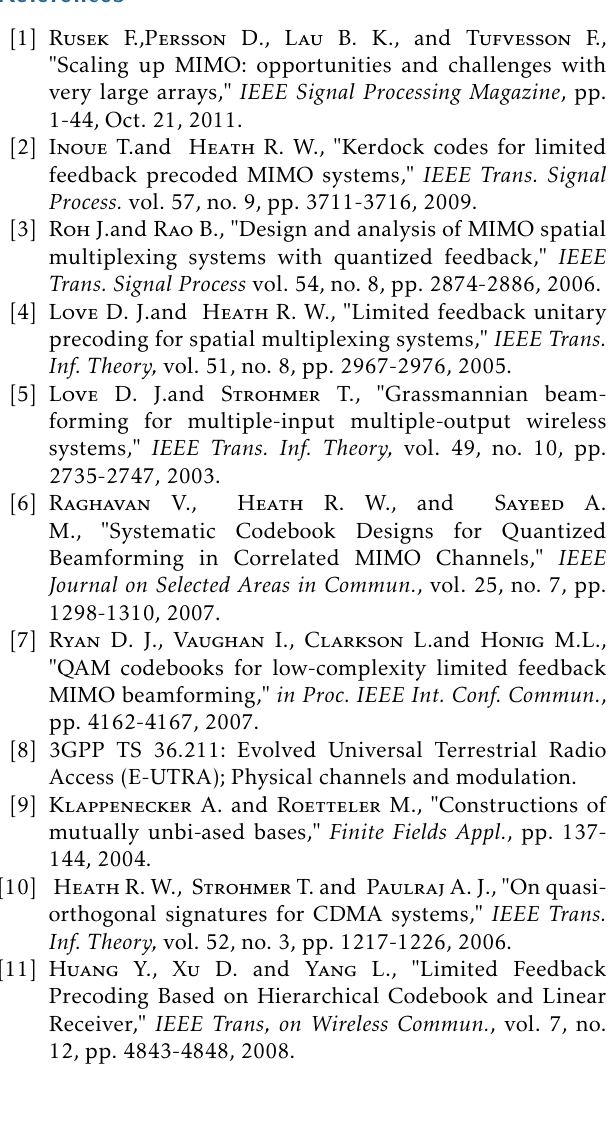
Figure 2. The BER Performance of Different Codebooks (little SNR differences)